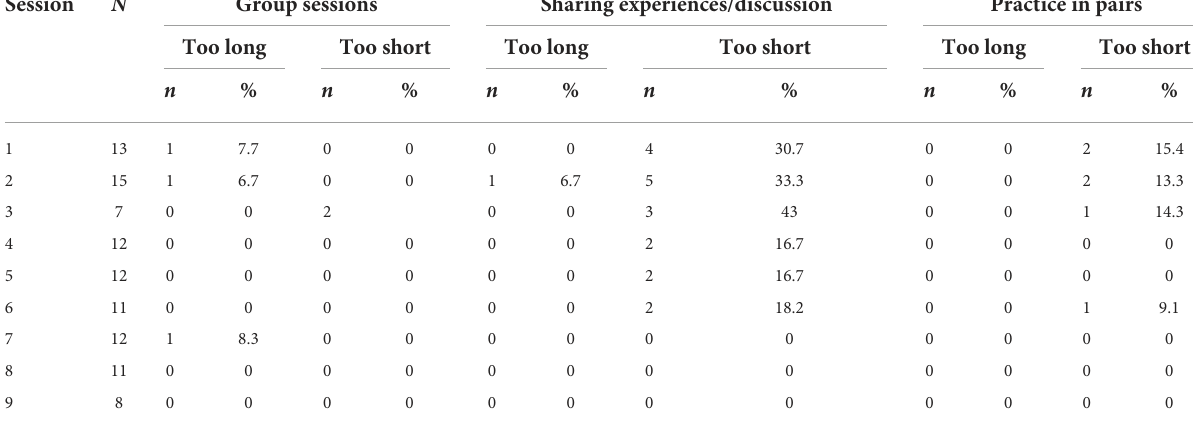
TABLE 6 Caregivers-rated acceptability of the duration of the different activities of groups